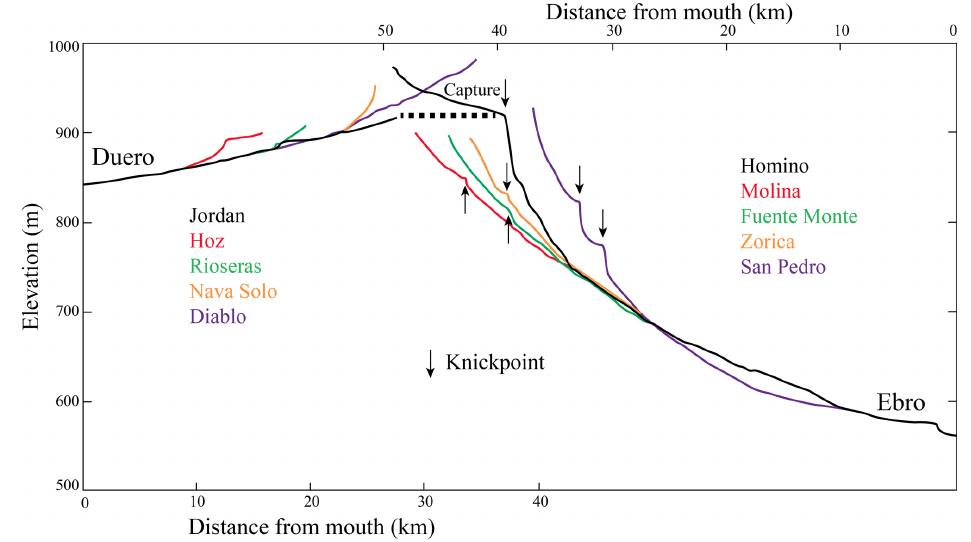
Figure 8. River long profiles for all the streams described in the Bureba area showing evidence of river capture. Colors are given to rivers that are linked in these capture